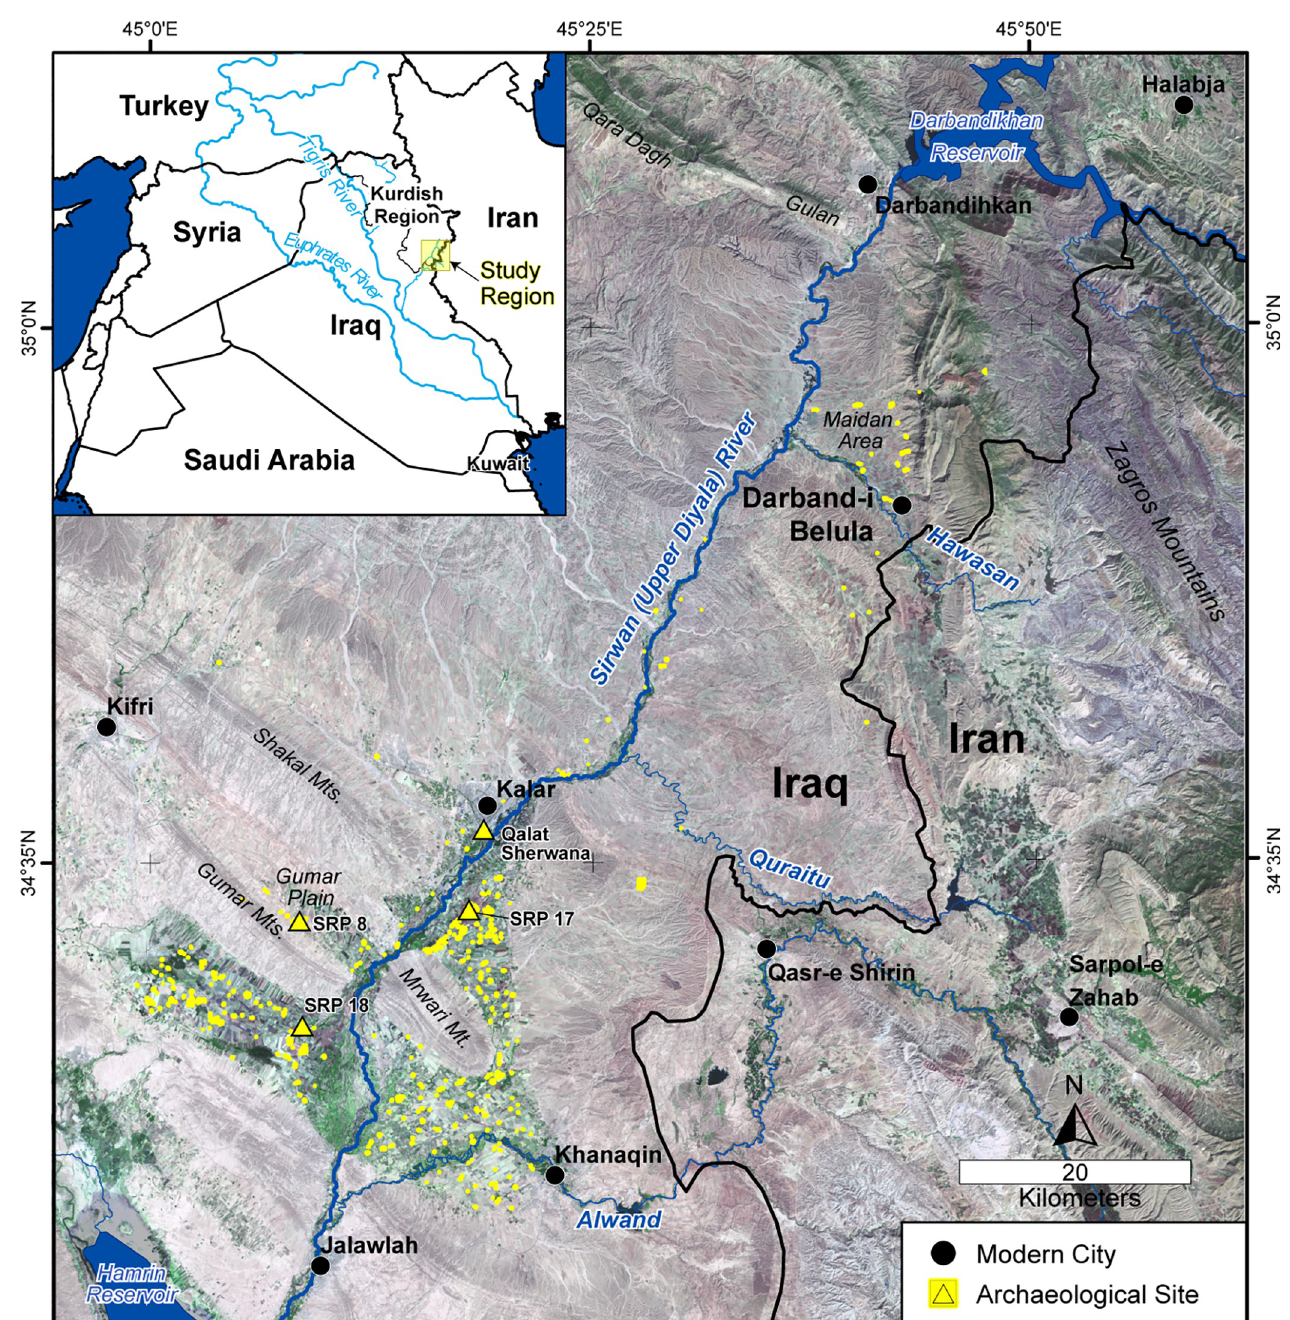
Fig 1. Map of the Sirwan/Upper Diyala River region in the Kurdistan Region of Iraq showing the location of sites monitored by the project (yellow). Archaeological sites highlighted in the text and figures are indicated as yellow triangles. The basemap is Landsat 8 natural color imagery (acquired 4 October 2021) freely downloaded from http://earthexplorer.usgs.gov (courtesy of the USGS and